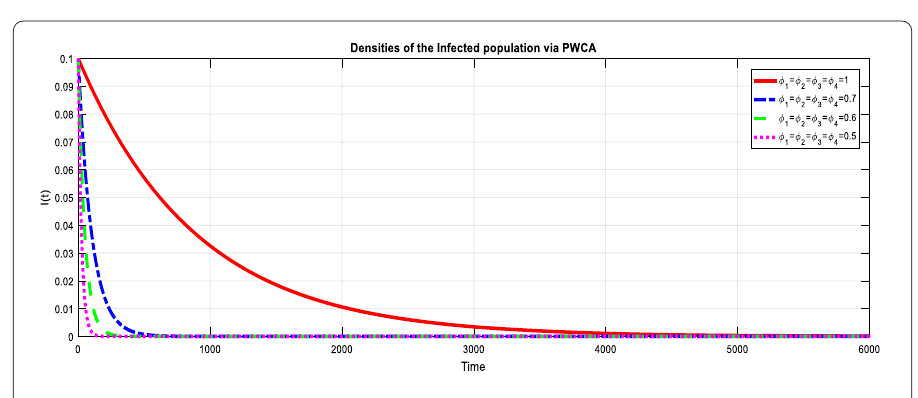
Figure 11 Dynamic of I ( t ) by varying the value of